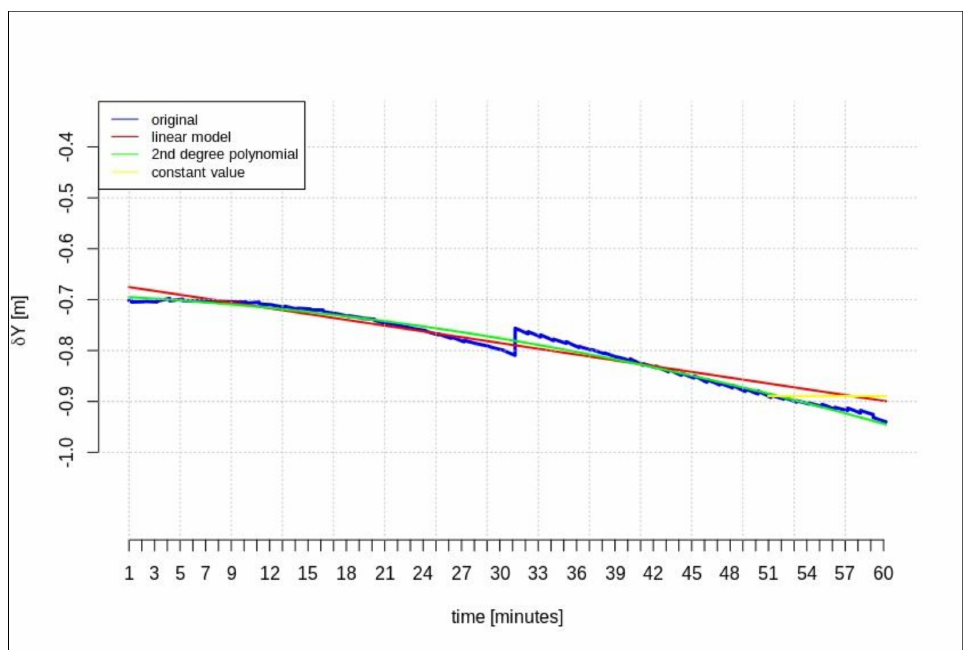
Figure 12. The results of δ Y geocentric correction extrapolation (GPS G28) for a 60-min data-stream between each IODE.